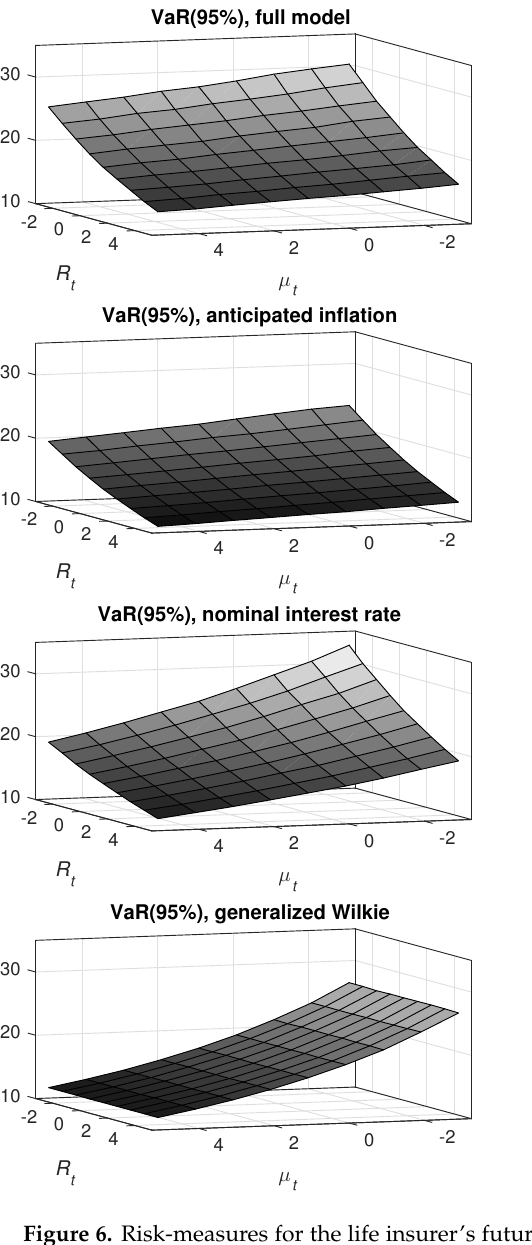
Figure 6. Risk-measures for the life insurer’s future payments, in present value. Values-at-risk and conditional tail expectations are computed under four inflation assumptions: full model, anticipated inflation, nominal interest rate, and the generalized Wilkie model. The confidence level is set at 95%. Values are reported in millions. Computations are done using the parameters of Tables 4 and 5. Real interest rate ( R t ) and expected inflation rates ( µ t ) displayed in the figure are in percentages (annualized). The conditional variance is set to its unconditional average w (i.e., 9.1318 × 10 − 7 ). Monte Carlo simulations are used to compute the risk measures. A sample of 10 5 observations are generated to compute each